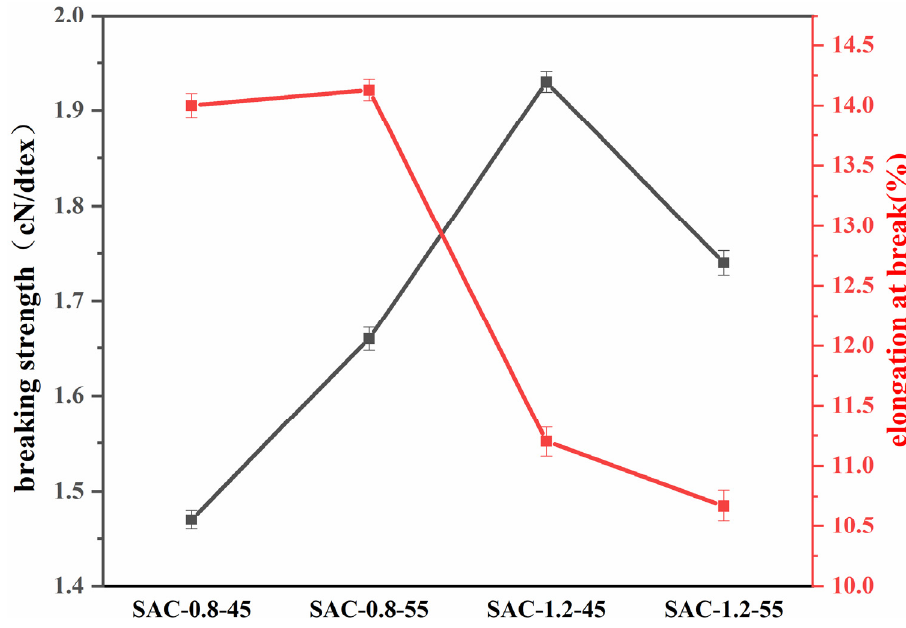
Figure 6. The tensile strength and elongation of SA/AKP/CNCs composite